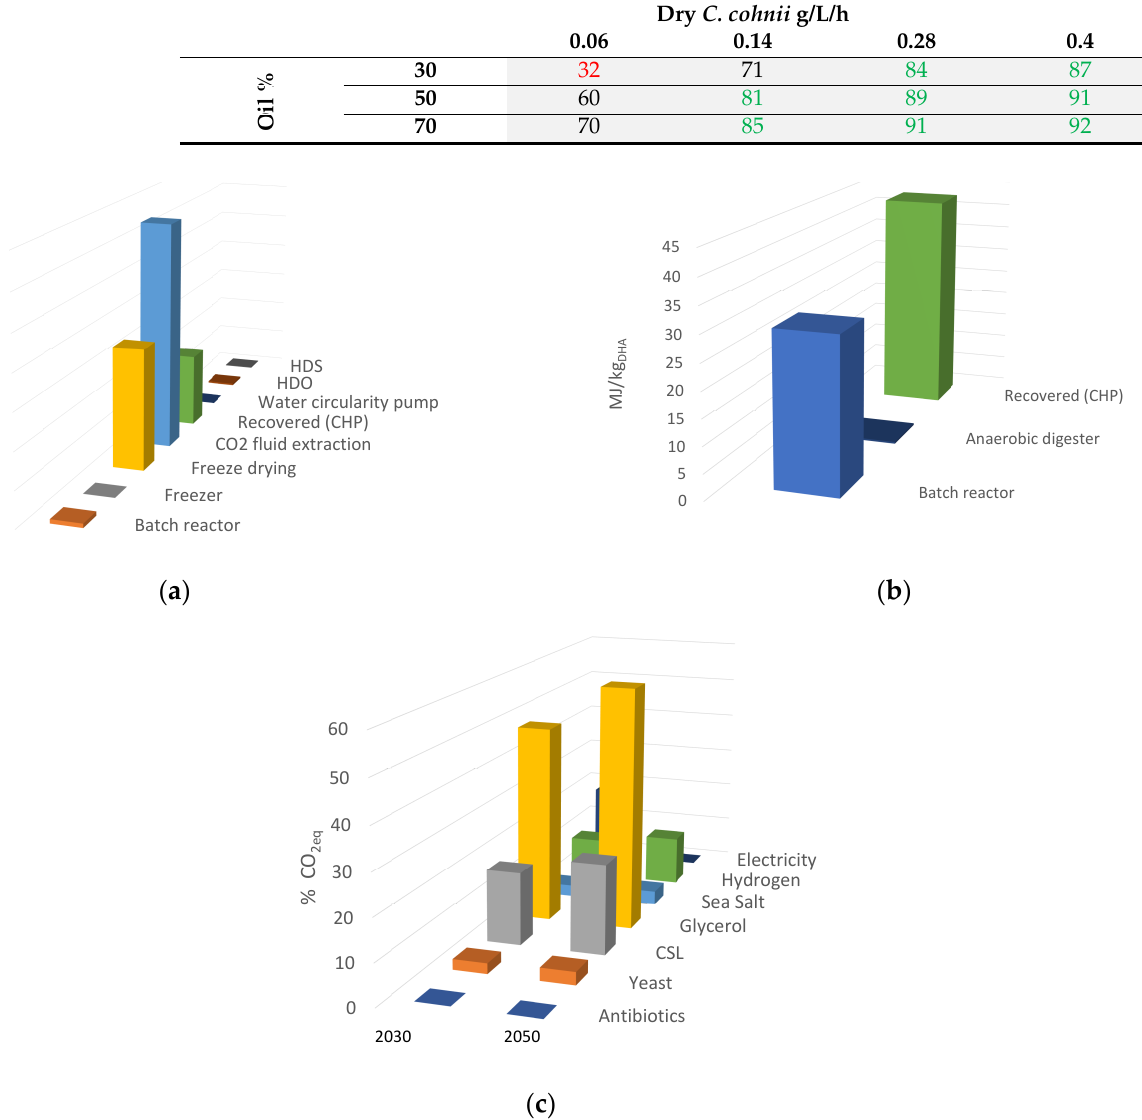
Table 4. Matrix of relative GHG emissions savings as a function of average productivity 0.06–0.4 (g/L/h, dry cell, L of working volume) and oil content of 30–70 wt.%. Actual bench-scale data is marked in red [26]. Green values show GHG emission savings higher than 70%.